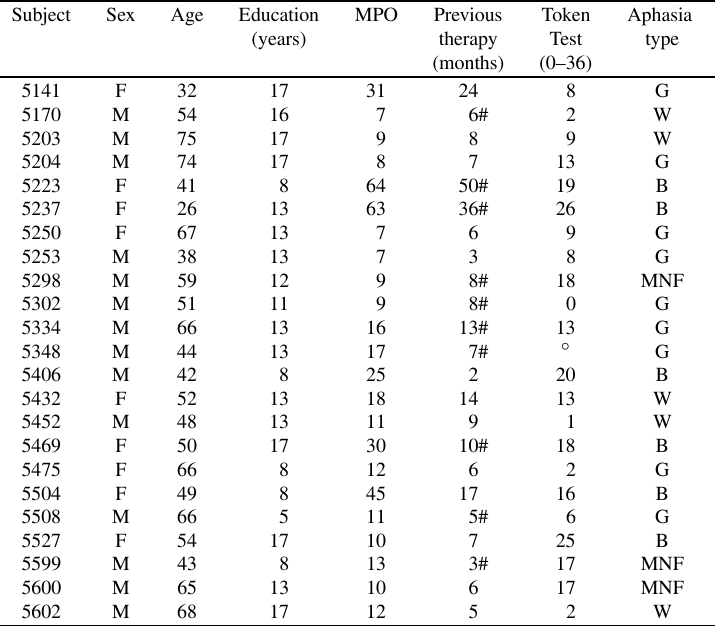
Table 1 Demographic and clinical data ofthe 23 subjects treated forat least 6months (Group